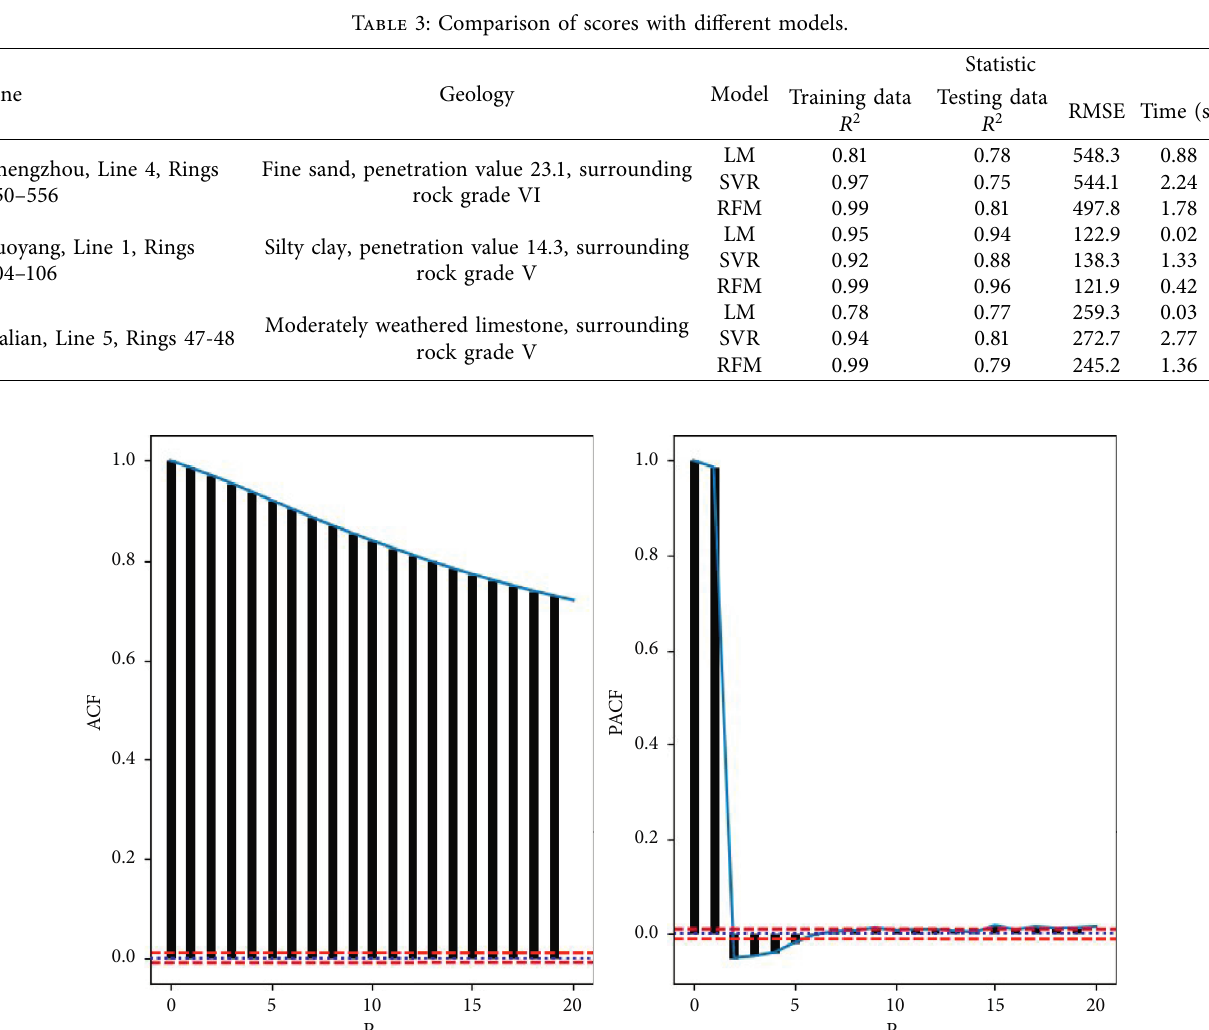
Figure 10: ACF and PACF charts for cutterhead